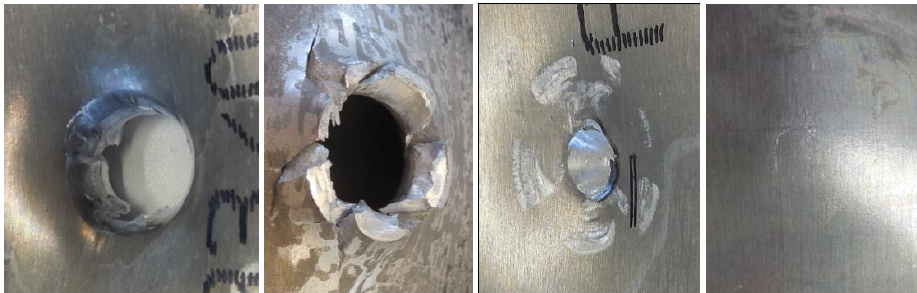
Fig. 1. Tests on single aluminium plate a. Residual vs. incident velocity. b. Rear side of the plate after impact at 230 m/s.